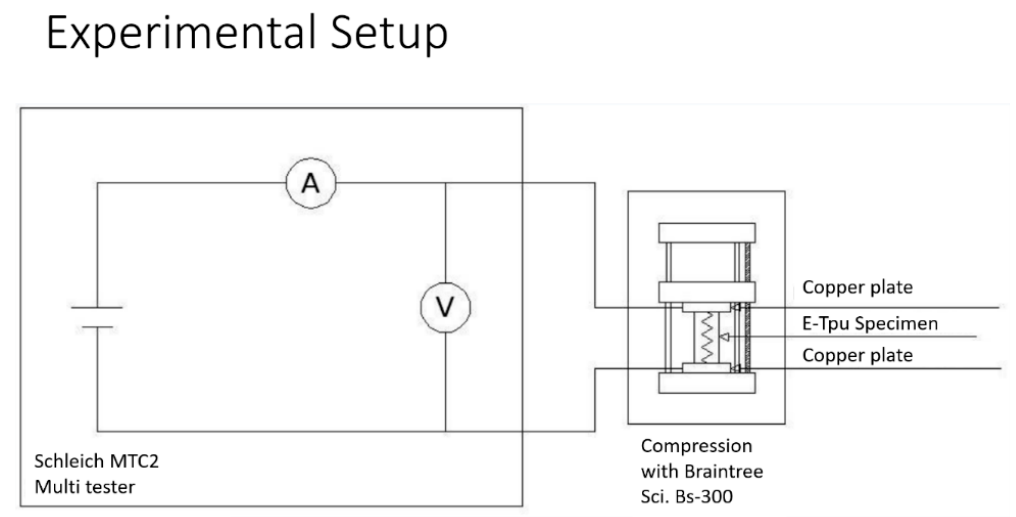
Figure 4. Experimental setup for the voltamperometric measurements.